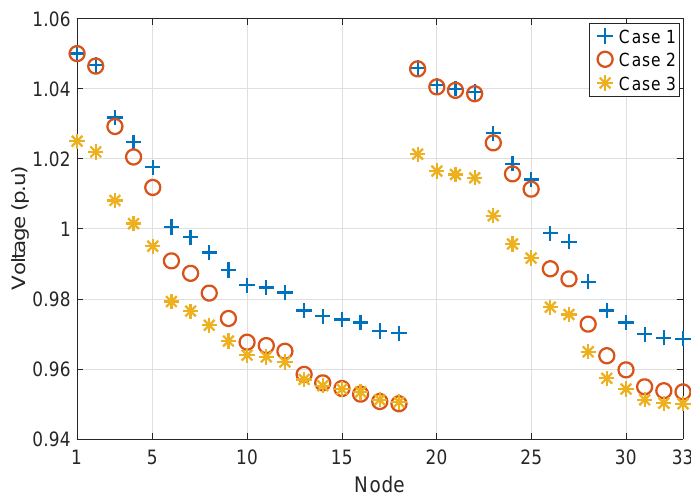
Figure 5. Voltage profiles at 2:00 p.m. in Cases 1, 2, and 3.